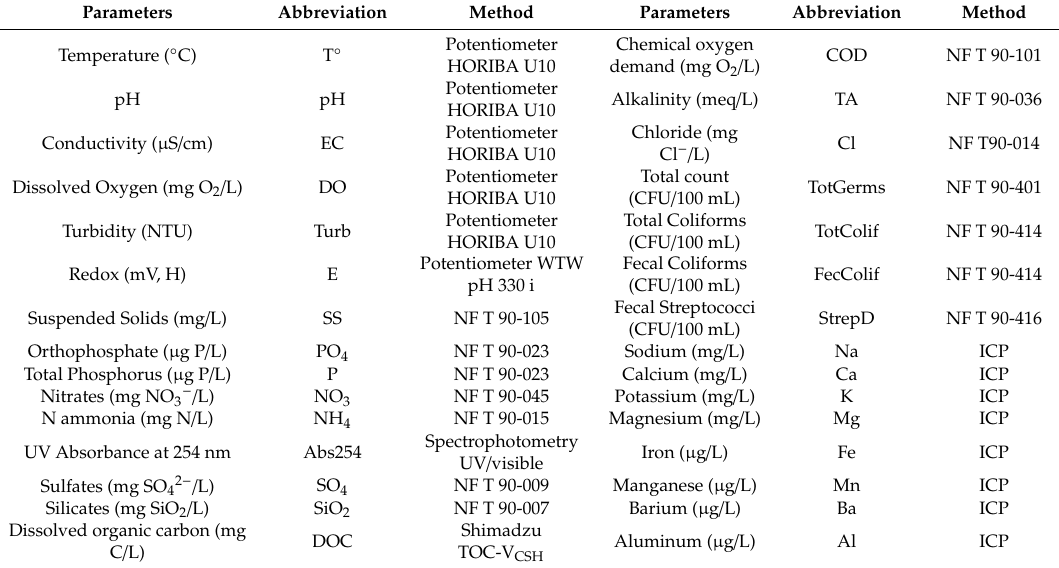
Table 1. List of studied parameters and methods applied for